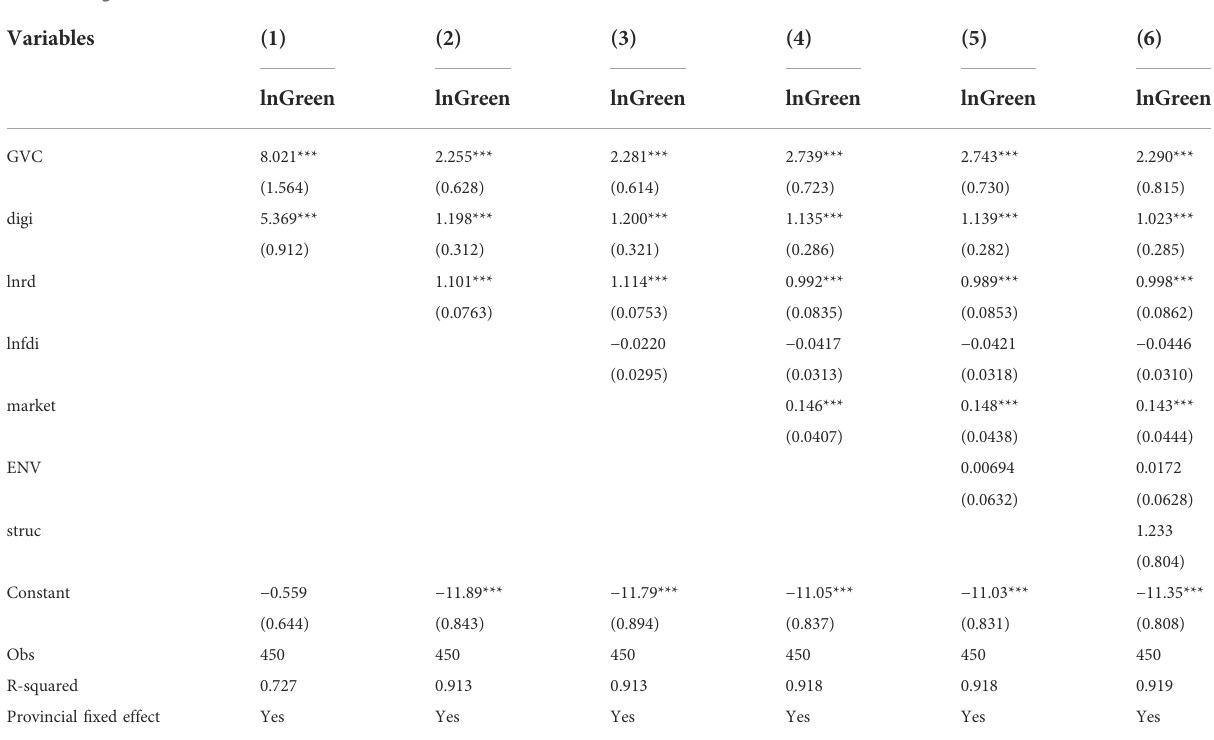
TABLE 3 Regression results of benchmark